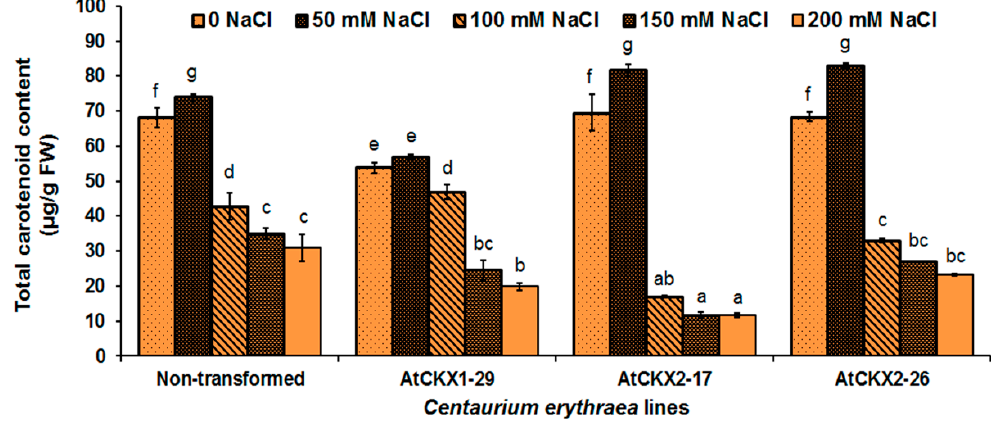
Figure 3. The total carotenoid content in the shoots of non-transformed and transgenic centaury lines ( AtCKX1 -29, AtCKX2 -17, and AtCKX2 -26) after 8 weeks of growth on ½MS medium supplemented with 0-, 50-, 100-, 150-, and 200-mM NaCl. The data represent the mean ± standard error. Means marked with a different letter are significantly different from the control, according to the LSD test ( p ≤ 0.05).